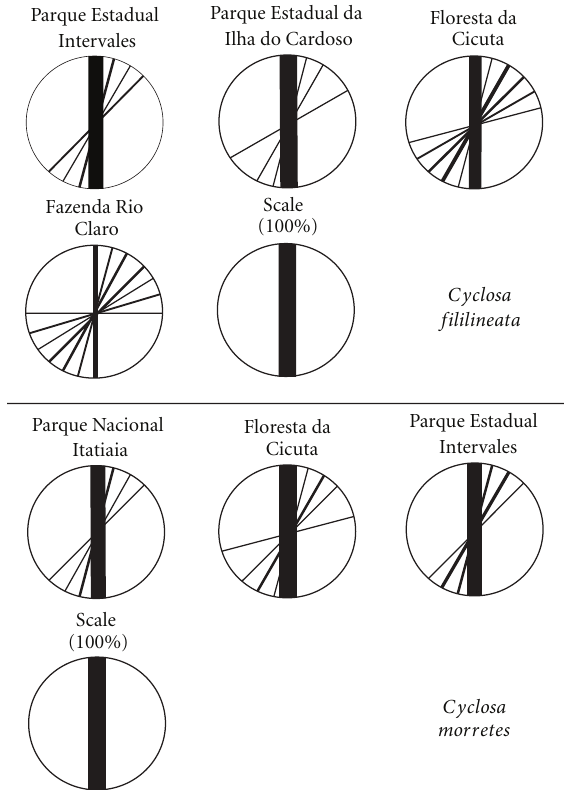
Figure 5: Frequencies of the inclinations of the stabilimenta constructed by C. fililineata and C. morretes . The inclinations were measured at 15 ◦ intervals and the thickness of each bar indicates the percentage of each category found in the field. Pooled results for juveniles and